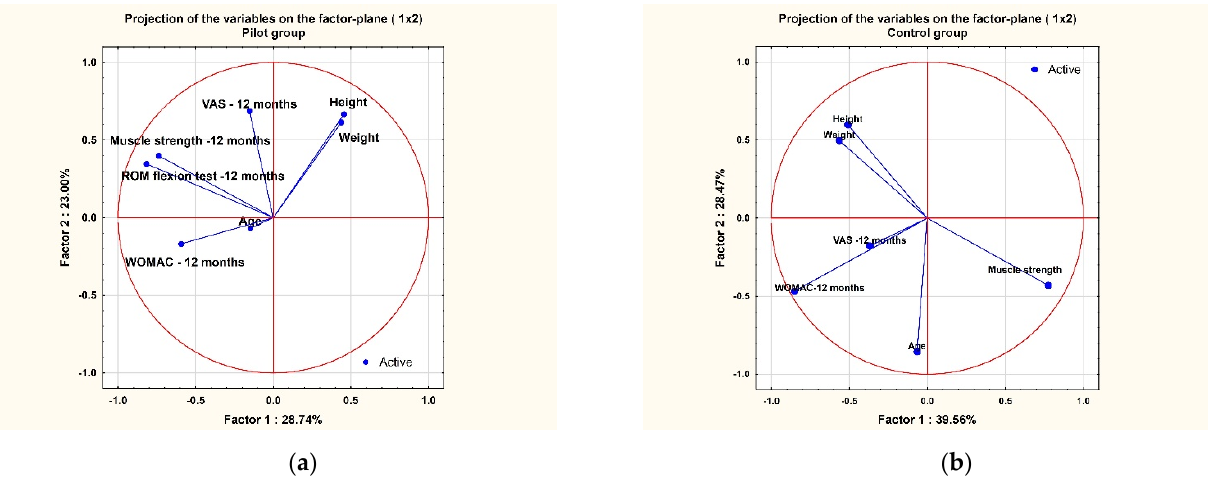
Figure 14. PCA analysis results for the ( a ) pilot group and ( b ) control group at 12 months. Table 16. Factor coordinates of the variables based on correlations with the pilot group (PG) after 12 months.